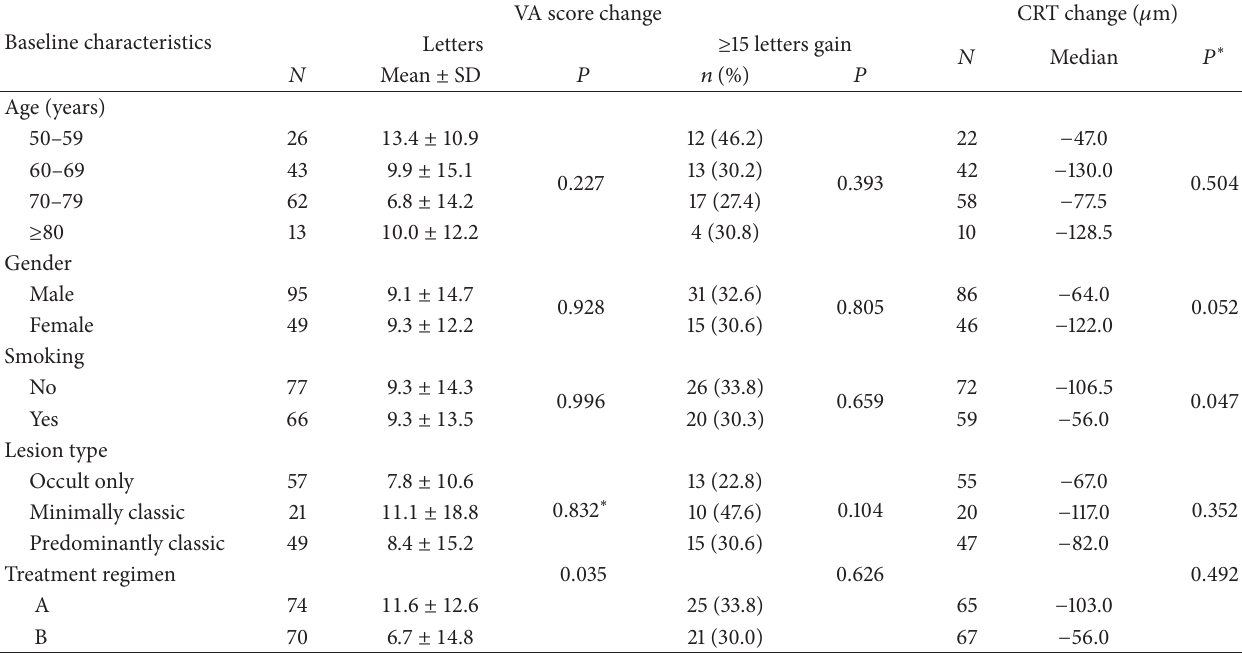
Table 2: Predictors of visual acuity score change and central retinal thickness change from baseline at 6 months. Baseline